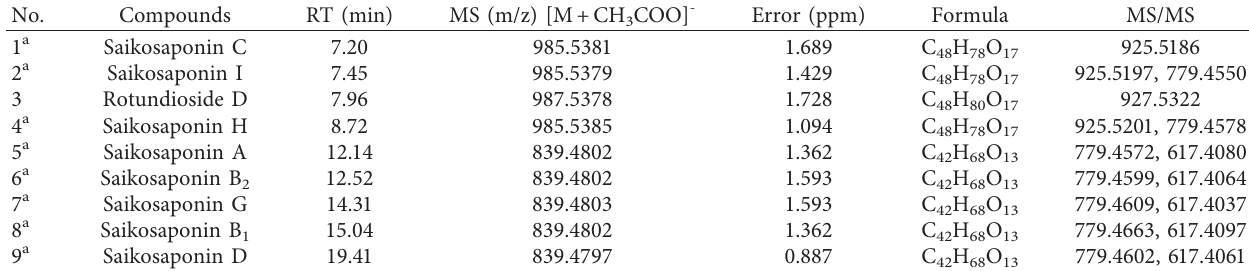
Table 1: LC-MS/MS data of investigated saikosaponins in XG and mixed standard solution.